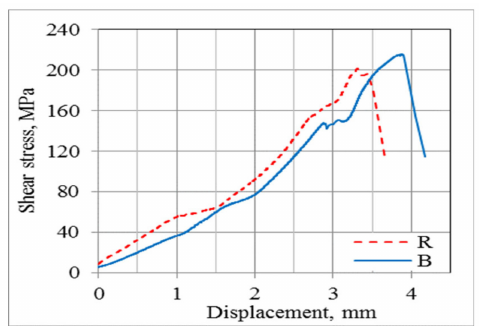
Figure 6. Stress-displacement diagram of transverse shear test for two HFRP bars with a mean of 14 mm.